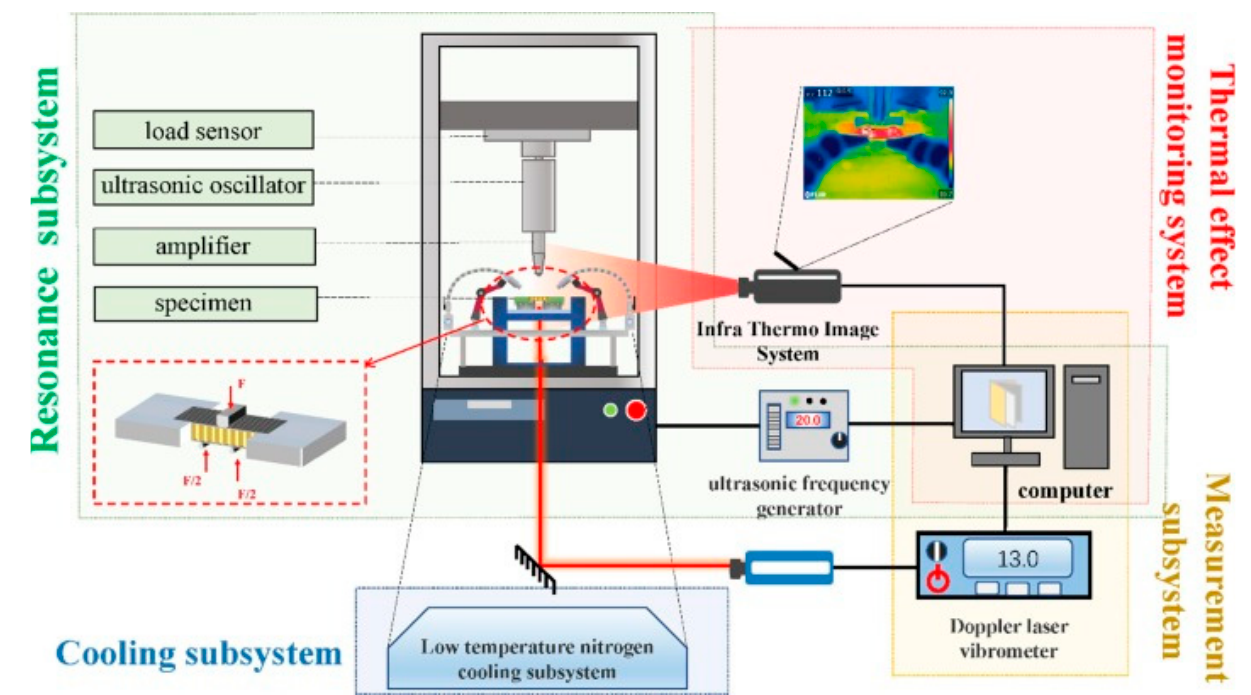
Figure 57. Schematic illustration of ultrasonic fatigue testing system, adapted with permission from Ref. [44]. Copyright © 2022 Elsevier Ltd.